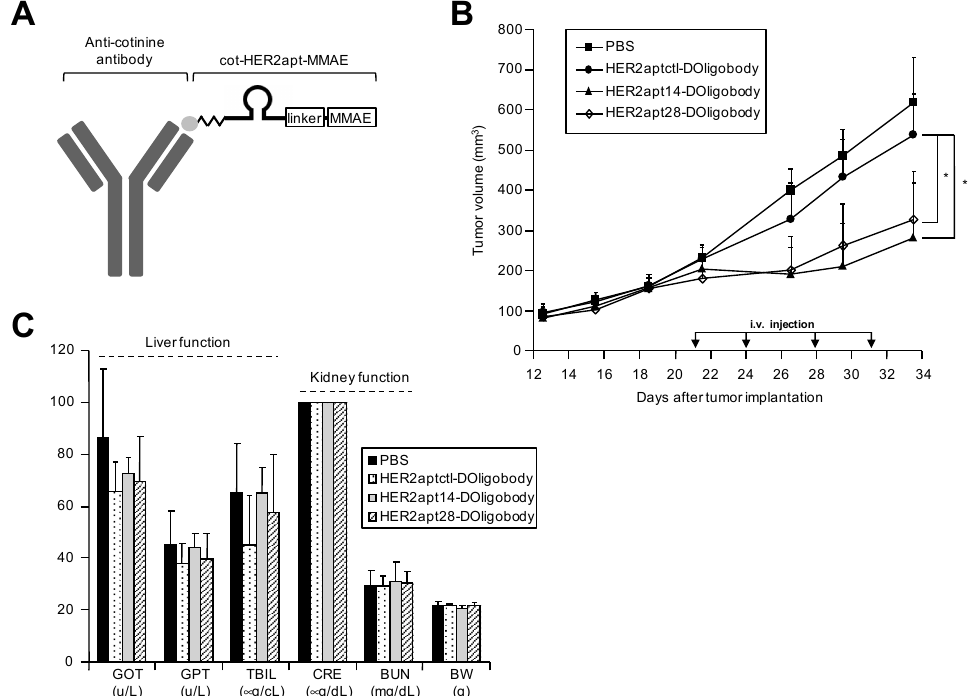
Figure 5. Anti-tumor activity of systemically administered HER2 DOligobodies in a mouse xenograft model. ( A ) HER2 DOligobody schematic representation. The DOligobody consists of the four elements: the cotinine (cot)-body, cot-linker, aptamer and monomethyl auristatin E (MMAE). ( B ) NCI-N87 cells (1 × 10 7 ) were subcutaneously injected into the flank region of BALB / c nude mice. When the tumors reached 200 mm 3 , the mice ( n = 10 per group) were intravenously injected with PBS ( ■ ), control HER2-DOligobody ( ● ), HER2apt14-DOligobody ( ▲ ), or HER2apt28-DOligobody ( ◇ ) (1.27 mg/kg cot-HER2apt-MMAEs pre-incubated with 10 mg/kg cot-body). Tumor volumes were monitored for 34 d. Data are shown as the mean ± standard error of the mean (SEM); * p < 0.05 compared with the control HER2-DOligobody group, Student’s t -test. ( C ) In vivo toxicity reflects changes in body weight of the mice and serum concentrations of GOT, GPT, BUN, CRE and TBIL measured 36 d after tumor implantation. All the data represent the means ± SEM from three independent experiments. GOT, glutamic oxaloacetic transaminase; GPT, glutamic pyruvic transaminase; TBIL, total bilirubin; CRE, creatinine; BUN, blood urea nitrogen; BW, body weight.